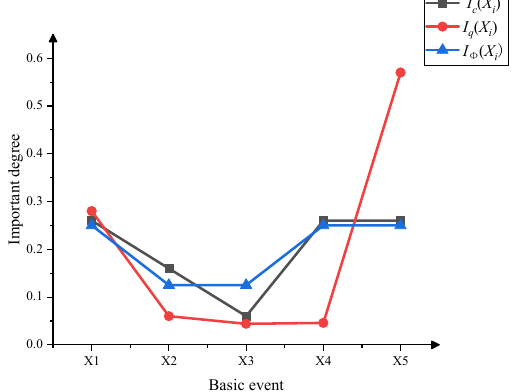
Figure 9. Comparison of three levels of importance.